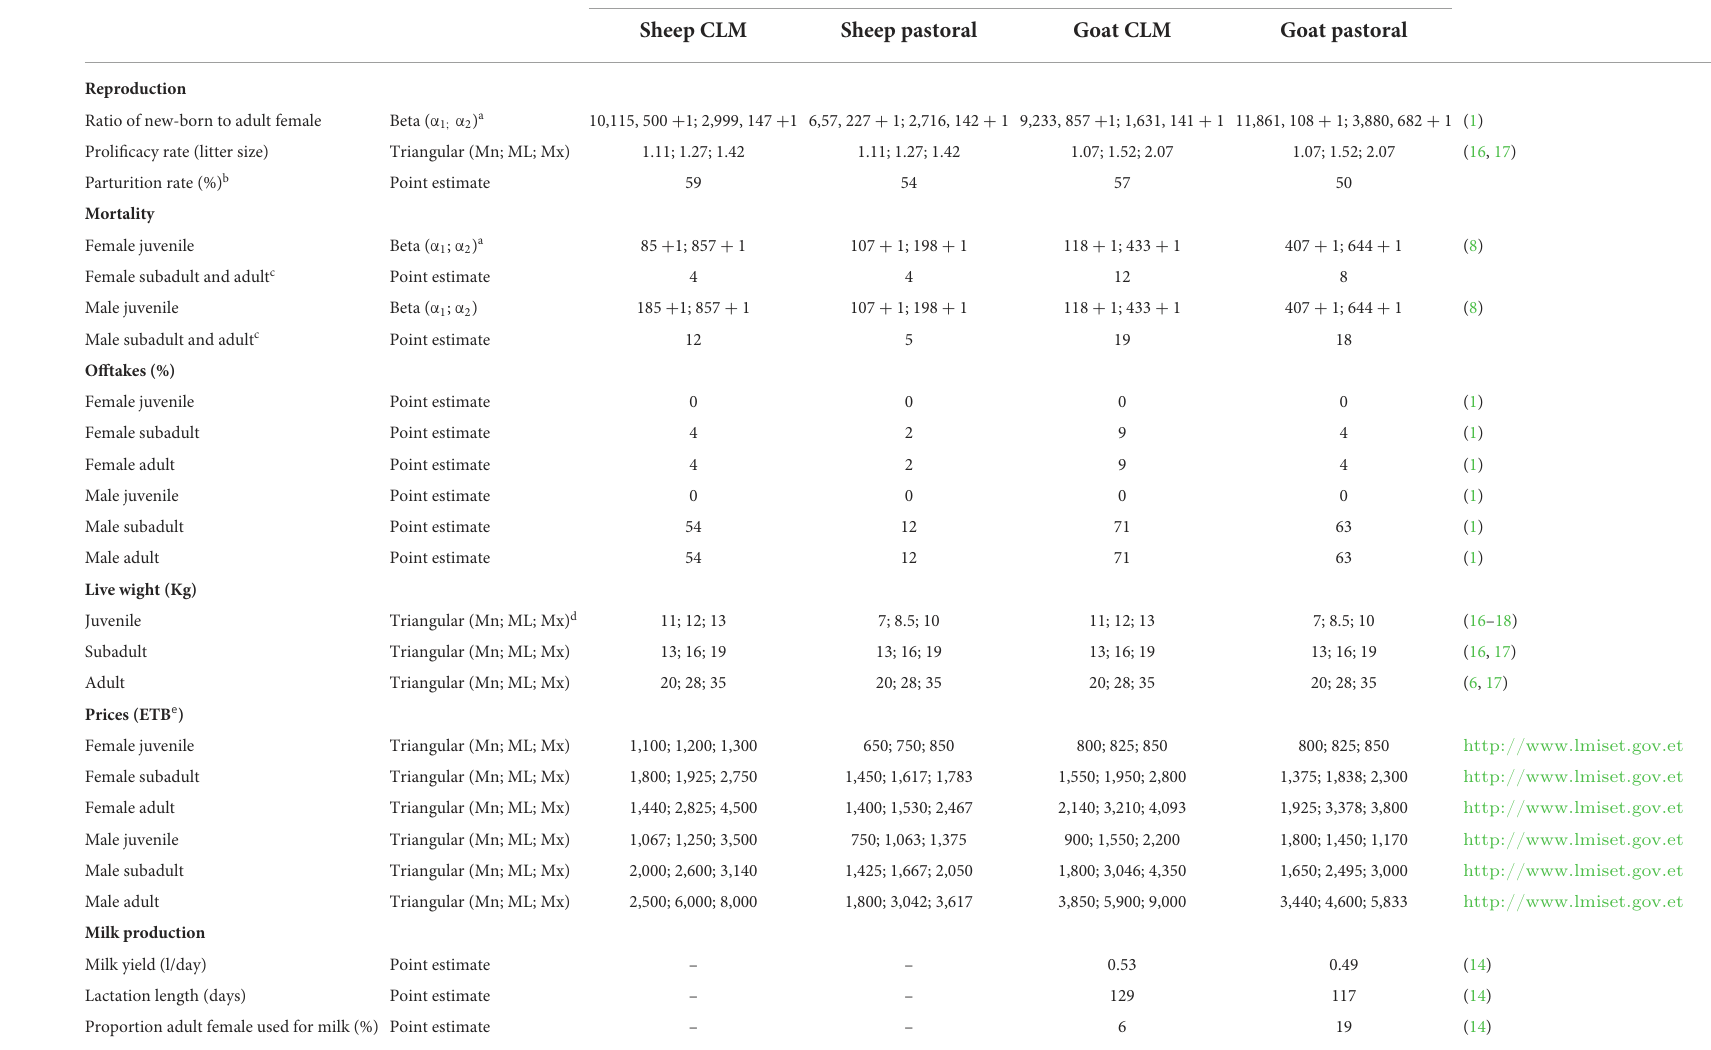
TABLE 1 Input parameters of the herd